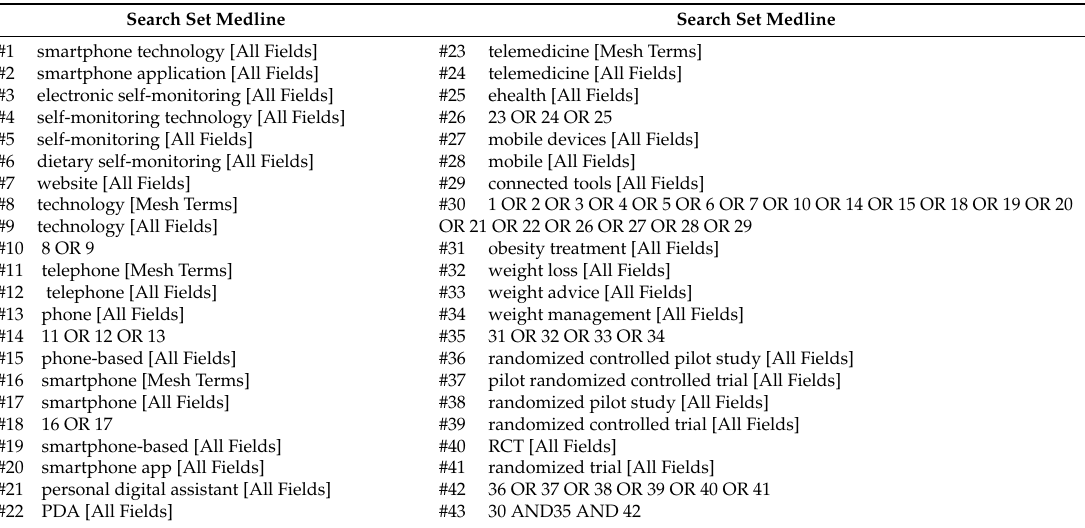
Table A1. Search strategy for the MEDLINE database.